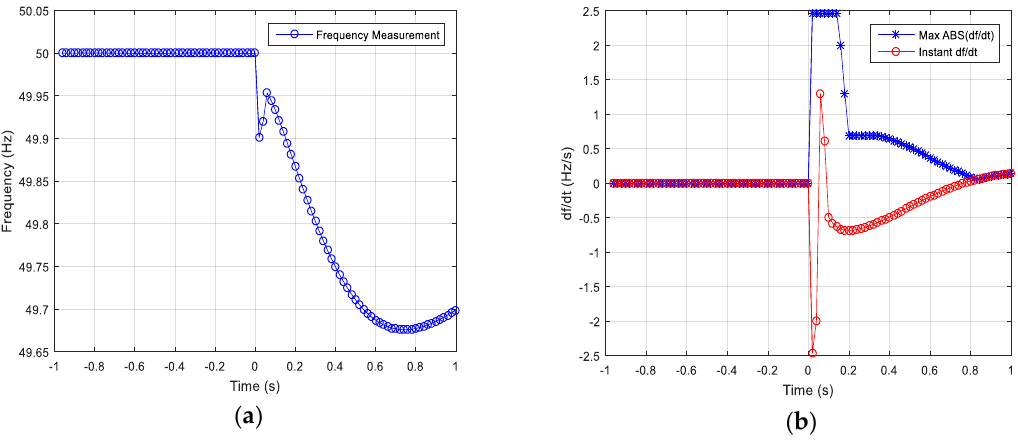
Figure 8. ( a ) System frequency measurement change; ( b ) maximum and instantaneous rate of change of frequency (ROCOF) values before and after loss of main grid.